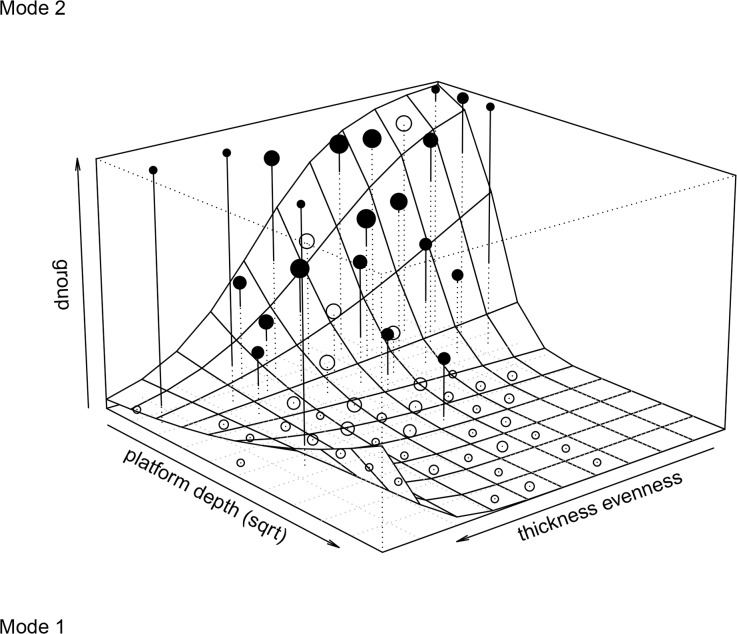
Generalized Linear Model-Platform depth * thickness evenness.The plot represents the effect of platform depth and thickness evenness on group separation at the average of EPA, curvature and raw materials. Points depicting the average response per cell of the fitted surface can be scaled according to the number of data in the respective cell and are depicted as filled when the average is above the fitted model and as open points when they are below. Points are connected to the bottom of the figure by a line, which is dashed between the bottom of the figure and the fitted surface, and solid above it.